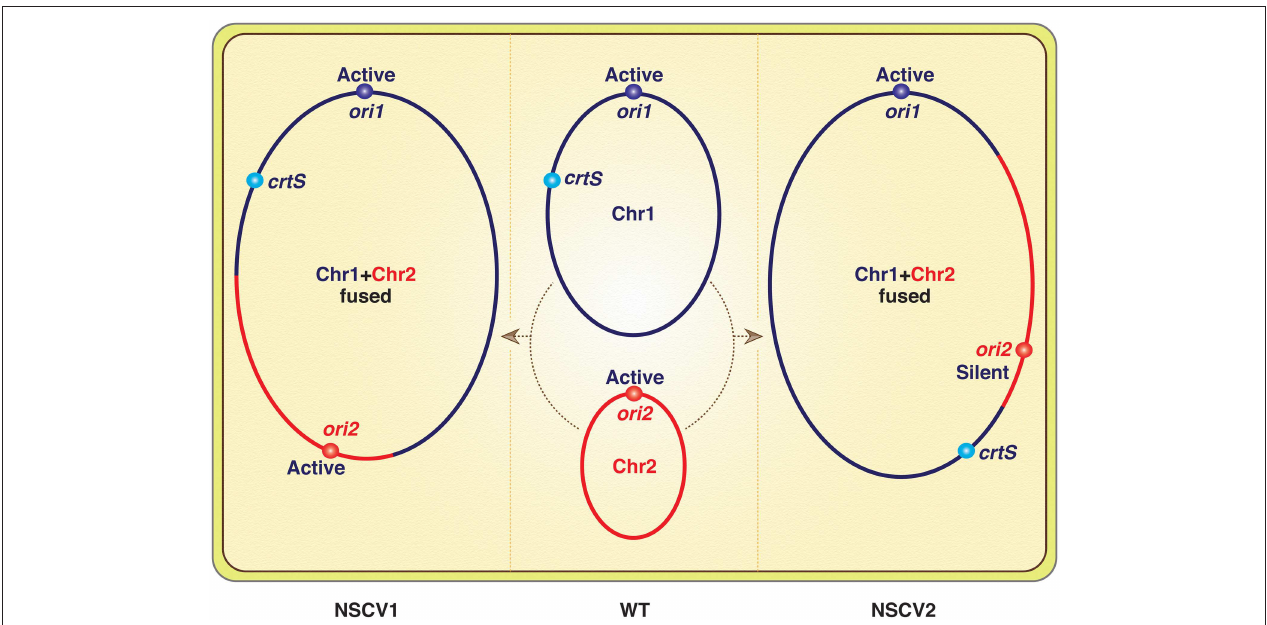
FIGURE 1 | Schematics of V. cholerae chromosomes (Chr1 and Chr2) before (in WT) and after fusions (in NSCV1 and NSCV2). Note that a replication fork emanating from ori1 will encounter crtS before ori2 in NSCV1 whereas the opposite will be the case in NSCV2. The inactivity of ori2 in NSCV2 is expected since crtS duplication is a prerequisite for ori2 firing, although the authors have reasons to believe that this may not be the real